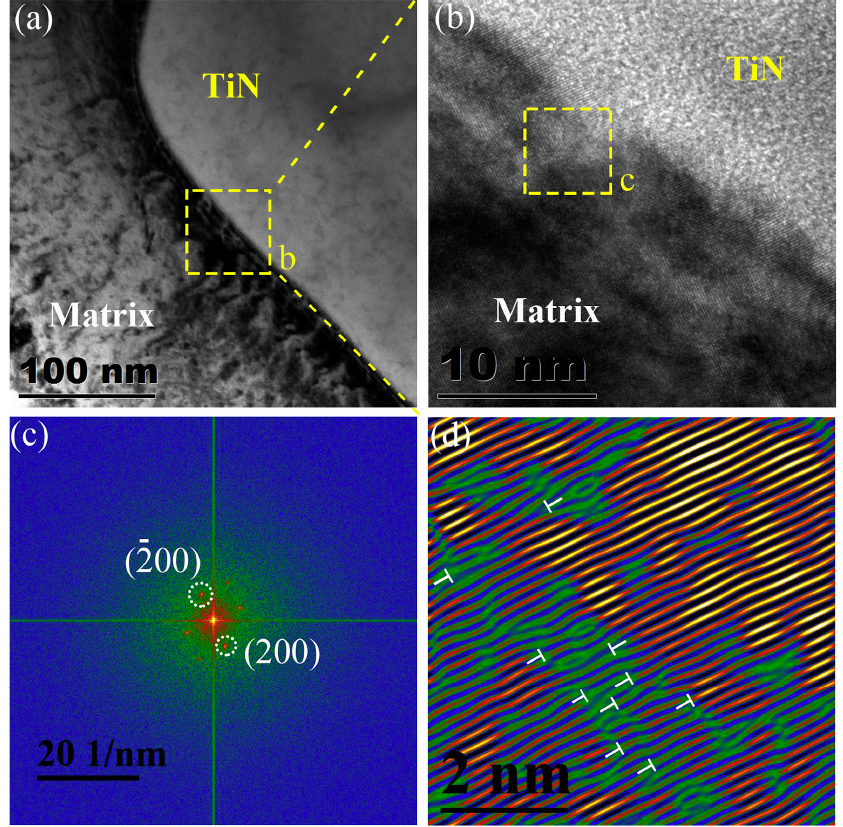
Figure 2. ( a ) The bright field image of the interface between TiN particle and matrix; ( b ) the HRTEM image of the interface between TiN particle and matrix; ( c ) the corresponding FFT patterns of yellow frame in ( b ); ( d ) the Inversed FFT image of ( c ) [59].